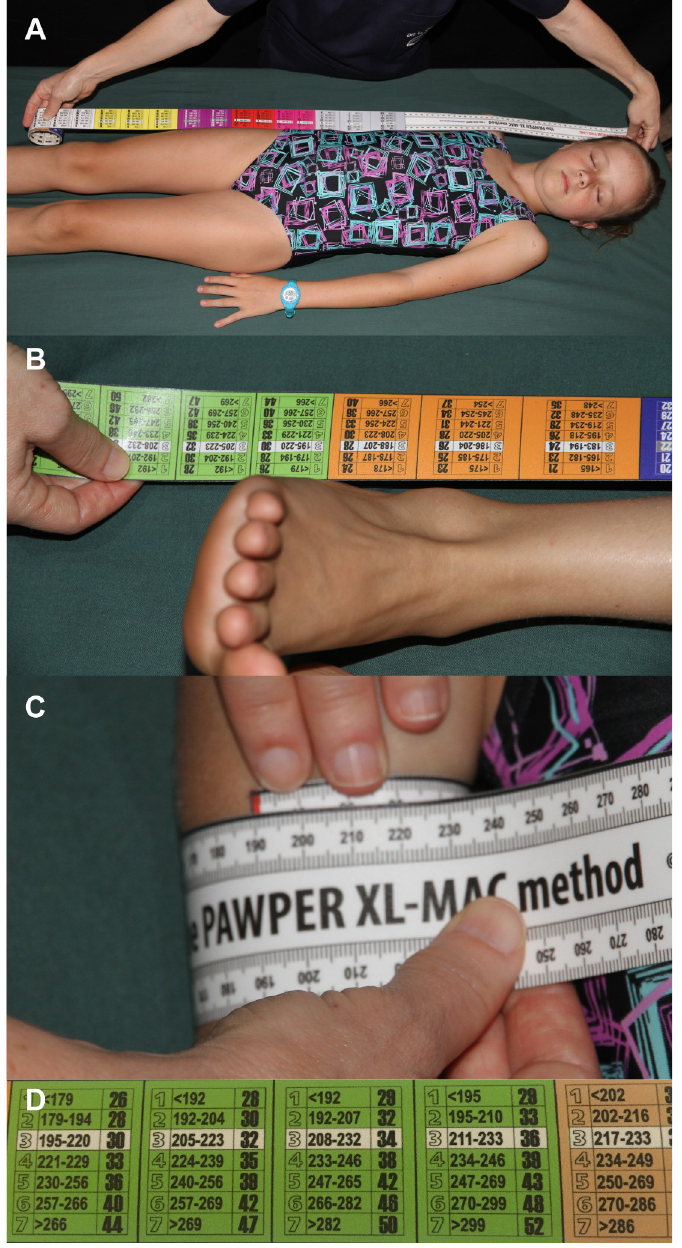
Fig 1. The PAWPER XL-MAC tape system. There are three steps to the use of the PAWPER XL-MAC tape. The first step is to measure the length of the child from his/her head to his/her heel (Panels A and B). The user thus identifies into which length segment the child falls. The second step is to measure the child’s mid-arm circumference using the tape (Panel C). The final step is to read off the estimated weight in the appropriate length segment based on the measured mid-arm circumference (Panel D). The user should be familiar and well-practised with the tape before using it in a resuscitation situation. length-segment of the tape contains MAC cut-off values which define the habitus category and allow the weight to be read directly off the tape.